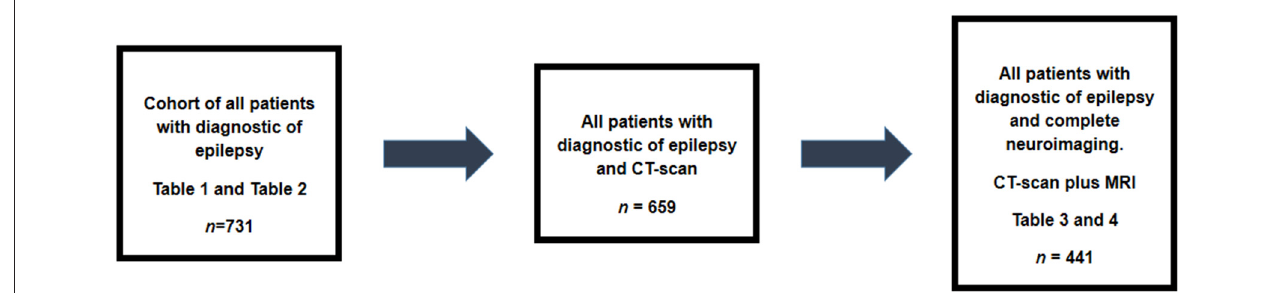
FIGURE 1 | Design of the study. Data of all 731 patient were collected. From these, 659 patients had CT-scans and 42 of them had imaging compatible with cNCC. Complete neuroimaging was available for reviewing in 441patients. The Tables showing main analysis done are included in this figure making easy to follow the steps of this study.